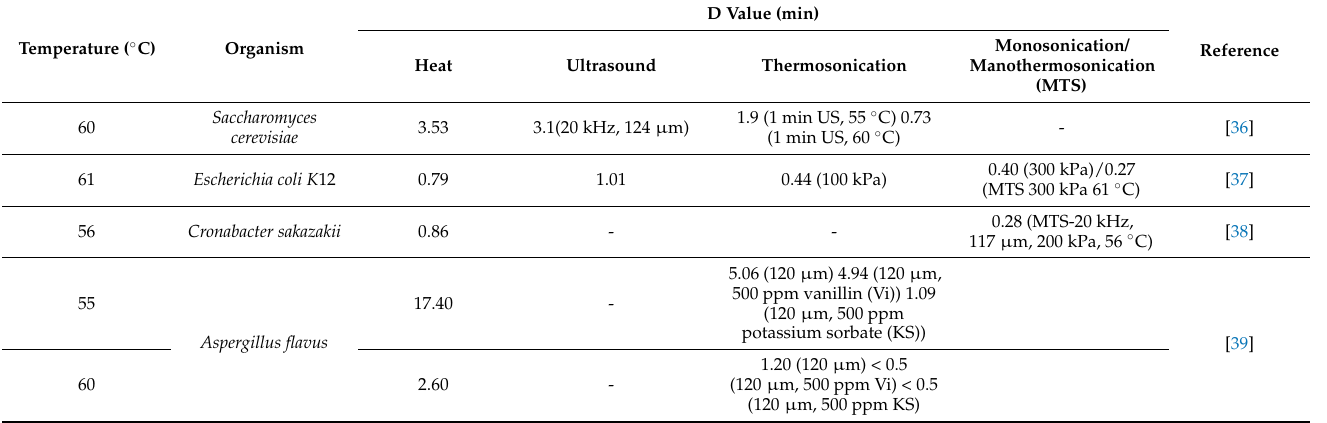
Table 1. D values of microorganisms inactivated by using heat, ultrasound, thermosonication, monosonication, and